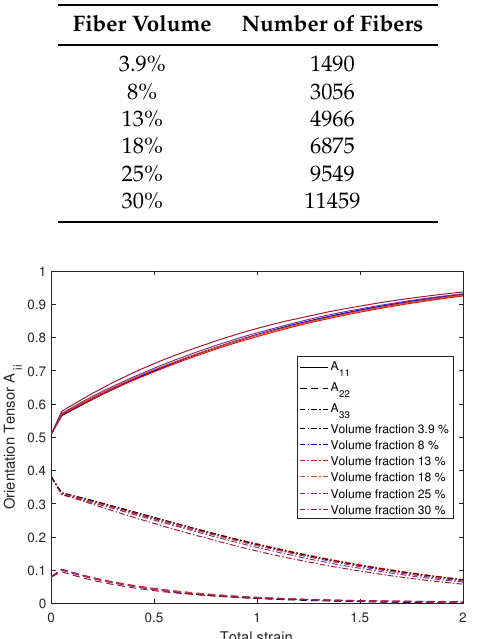
Figure 9. Fiber orientation evolution under elongational flow with different RVEs having different volume